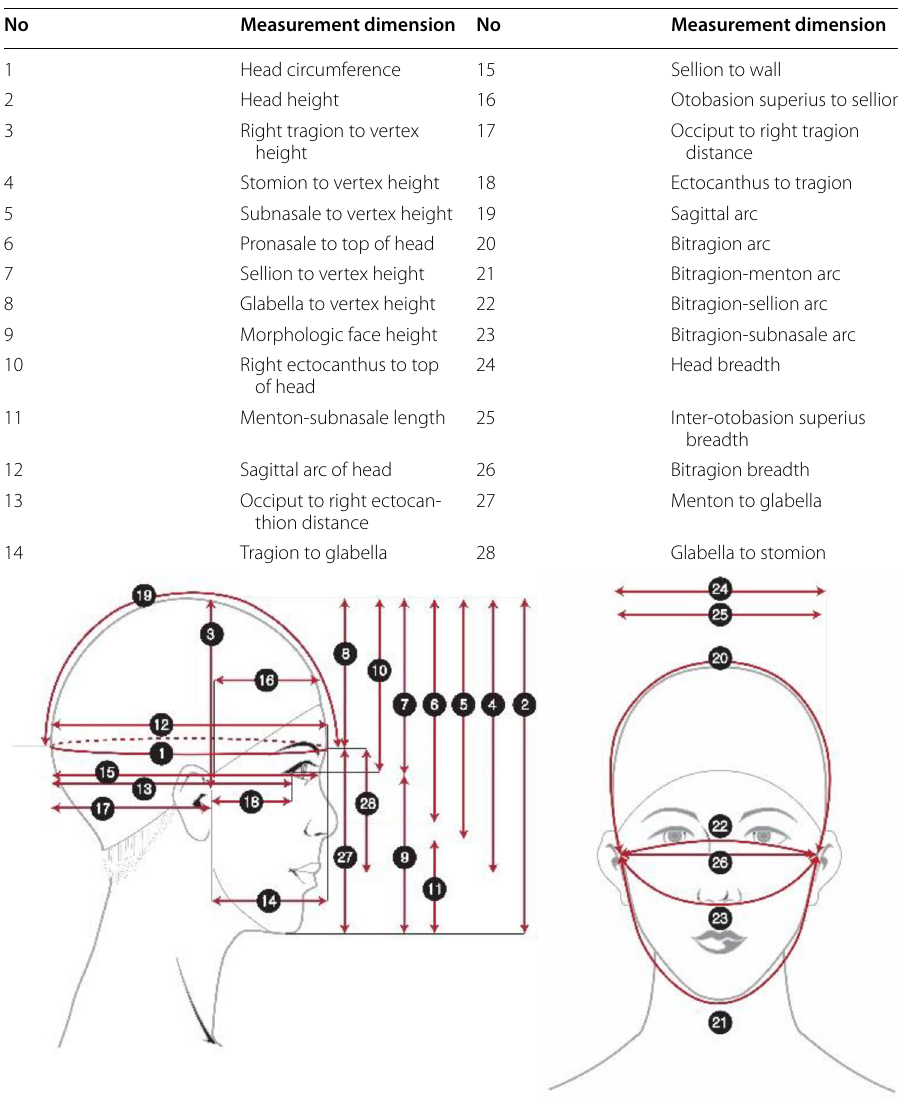
Table 1 3D head measurement